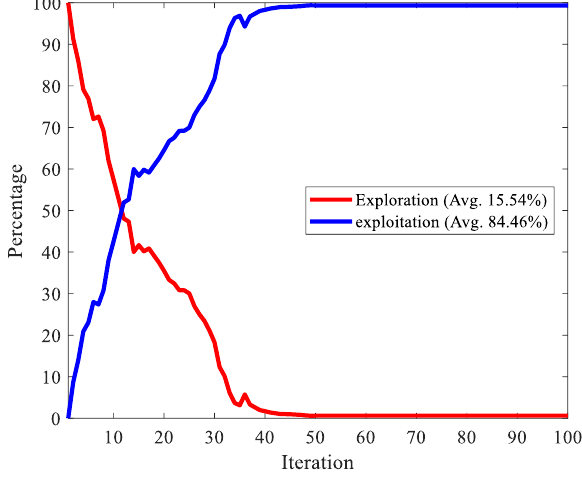
Figure 6. Balance analysis of SO .